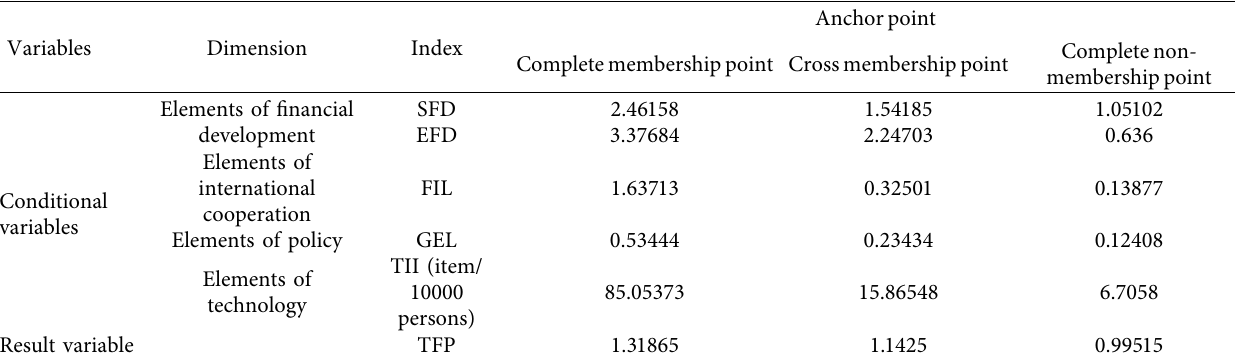
Table 3: Calibration anchor point for each